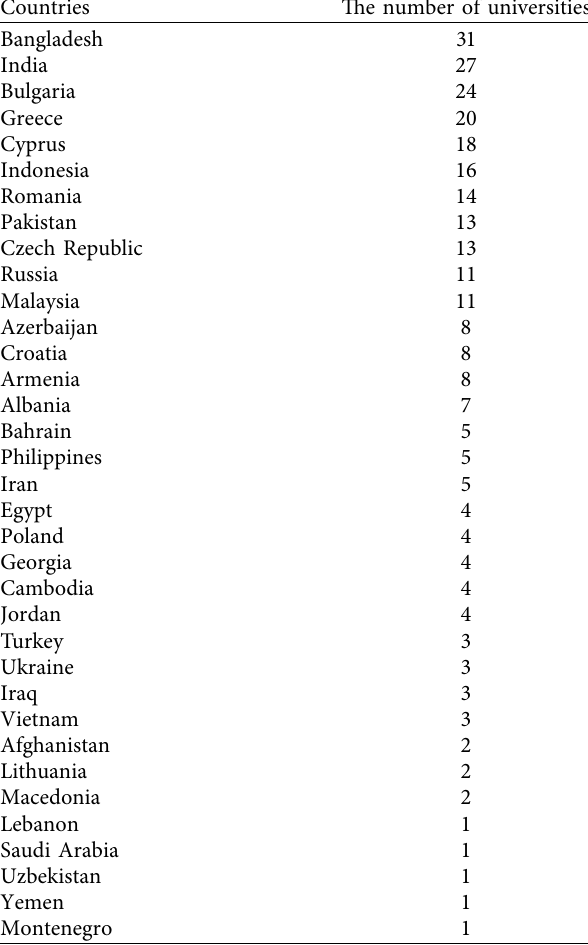
Table 1: The distribution of universities across